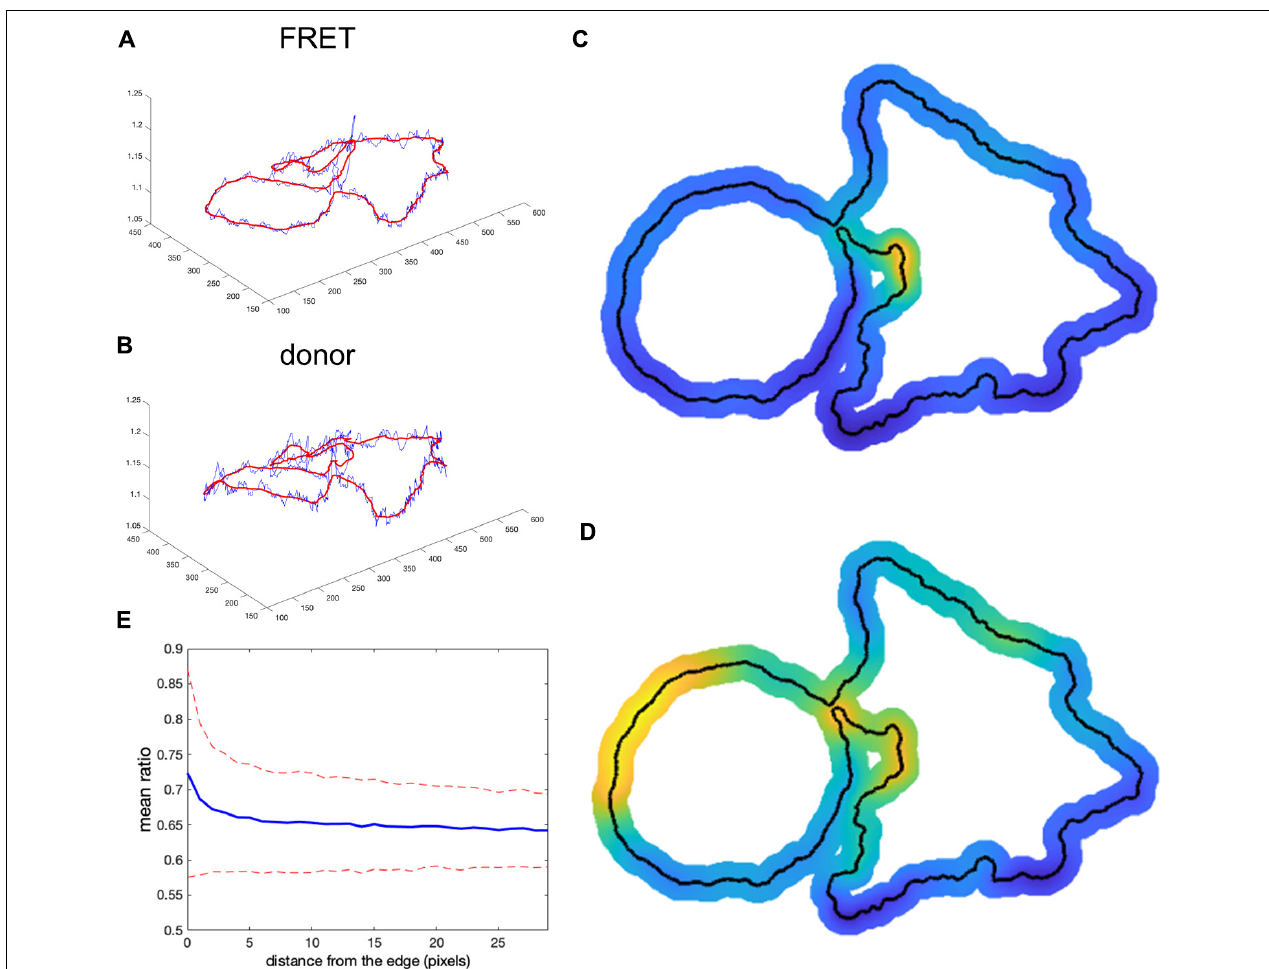
FIGURE 4 | Nonuniform background subtraction. (A,B) The fluorescence intensity in the FRET and donor channels outside the cell and near the edge (i.e., the local background along the cell periphery) is shown in blue. Smoothing these using a Gaussian filter generated the curve shown in red. (C,D) Spatial interpolation using the smoothed FRET and donor signals along the cell edge as the background for determining ratio values near the edge. (E) Mean ratio signal as a function of the distance toward the cell center from the edge, showing 12.7% deviation from the expected constant mean. This is due to the same edge artifacts shown in Figure 1 , but further exaggerated by small values of the ratio